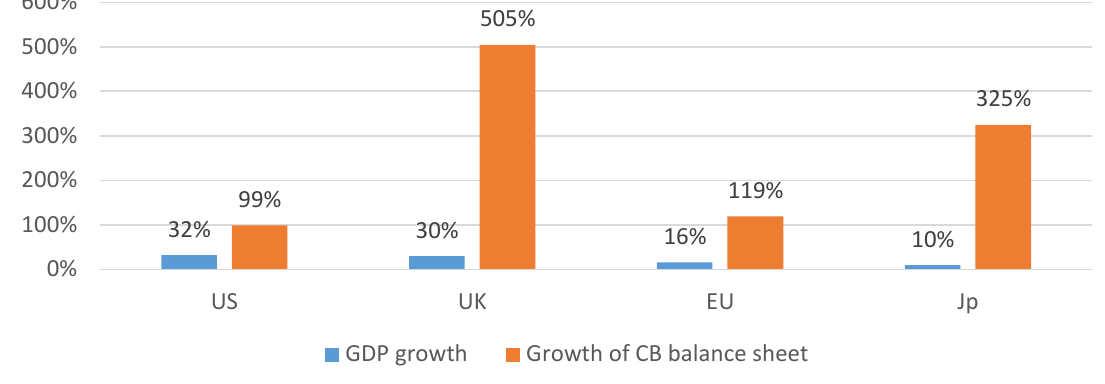
Figure 3. Growth of GDP and assets of the world central banks during the period